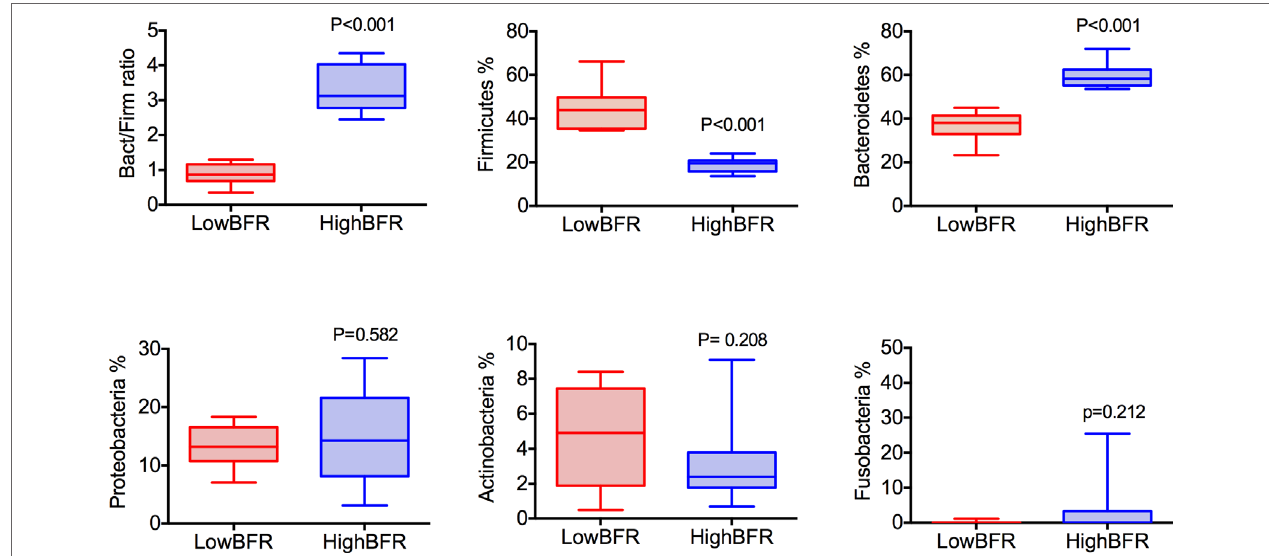
FIGURE 1 | Categorization of study patients into the HighBFR and LowBFR groups according to dominant bacterial phyla. Box plots (range min–max) show the Bacteroidetes-to-Firmicutes ratio and the relative abundance (%) of five more predominant bacterial phyla: Bacteroidetes, Firmicutes, Proteobacteria, Acidobacteria, and Fusobacteria. Comparisons between groups were performed using t test analysis (*** p <